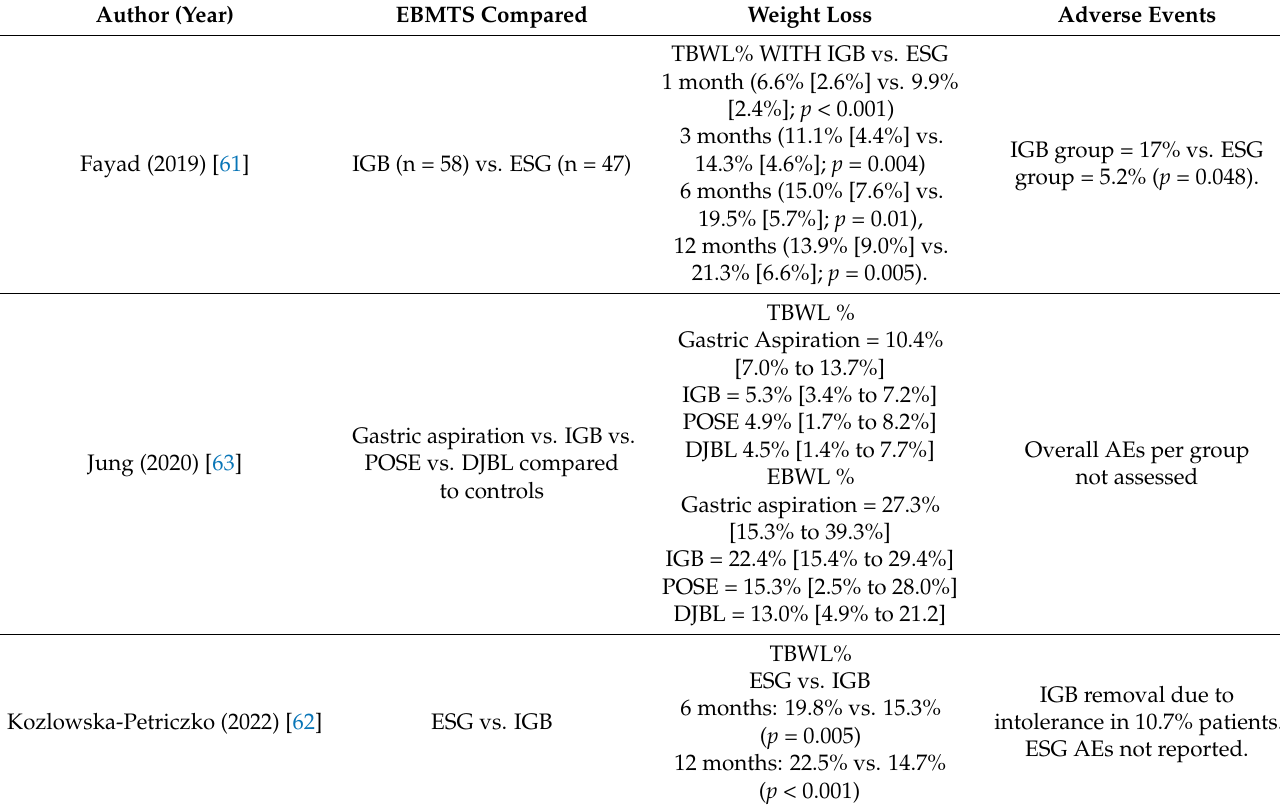
Table 4. Comparison of